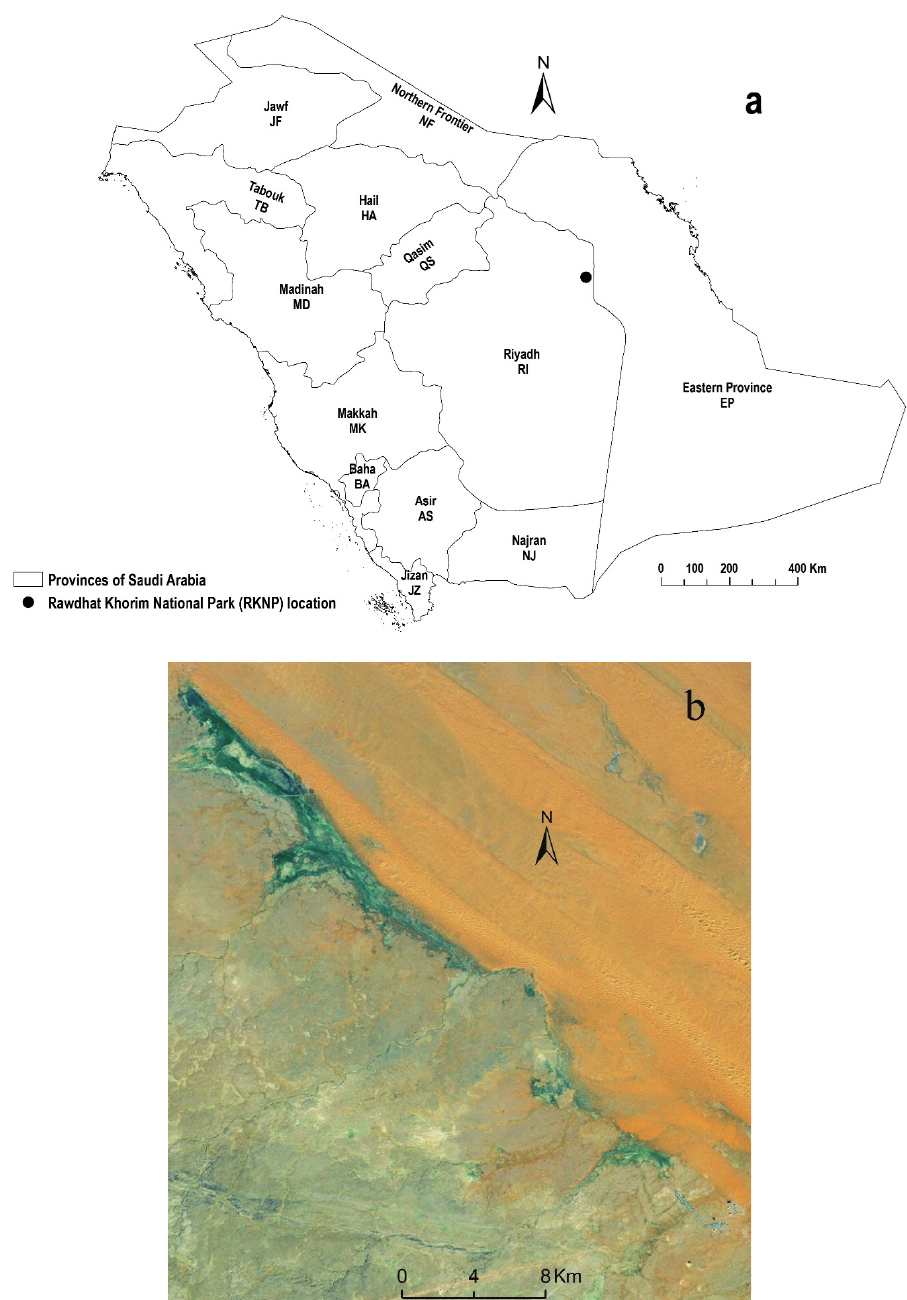
Figure 1. a Map showing the provinces and geographic location of Rawdhat Khorim National Park within the Central Region of Kingdom of Saudi Arabia b Photo of Rawdhat Khorim National Park (Produced by ArcMap